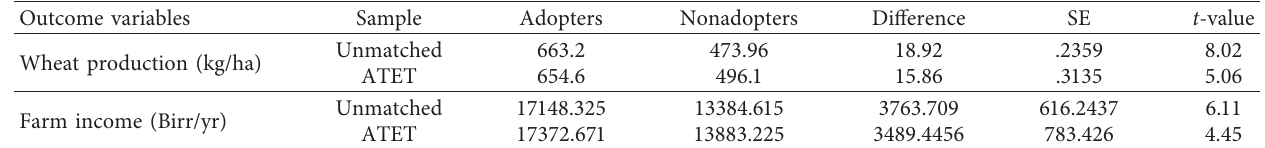
Table 12: Average treatment effect on the treated (ATET)